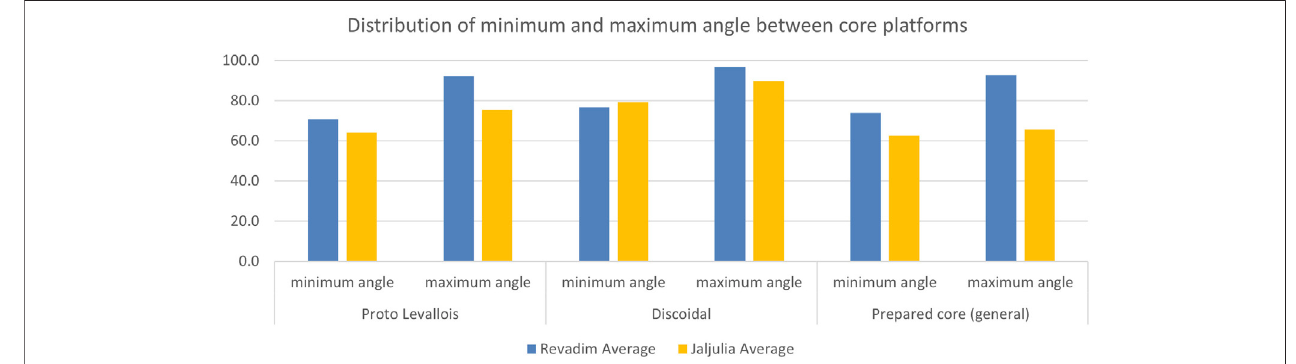
FIGURE 7 | Distribution of minimal and maximal angles between two core platforms for each method at both sites.